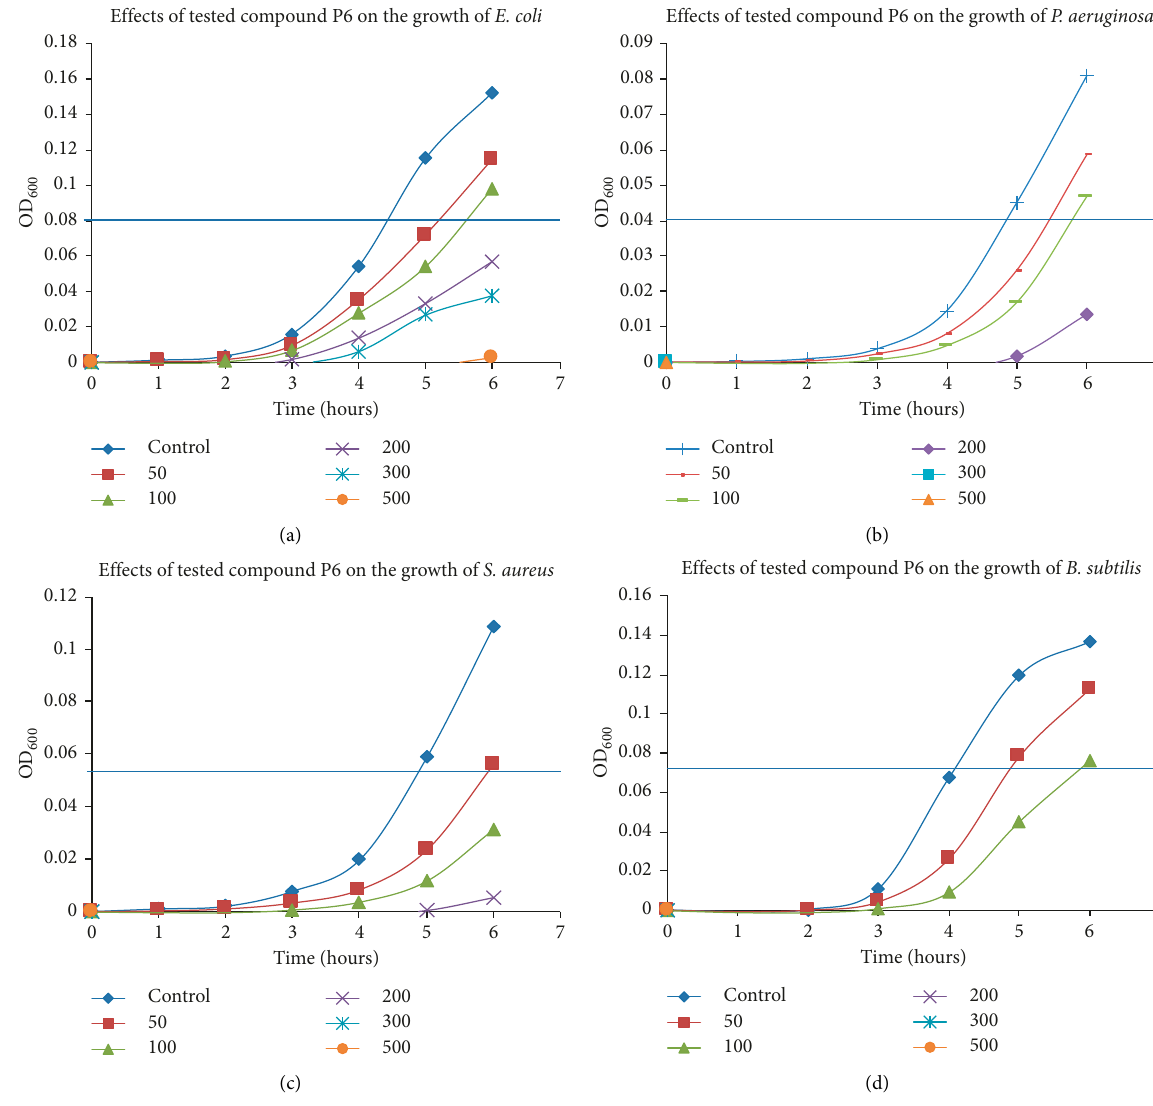
Figure 2: Effects of different concentrations of compound P6 against different time points. All compound concentrations are in µ